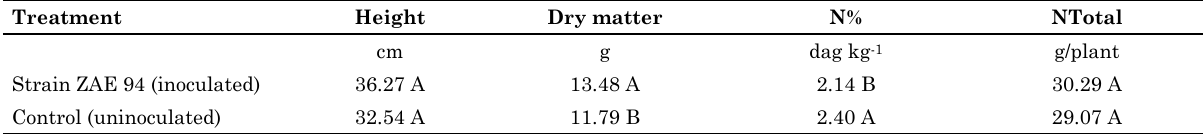
Table 1. Height, dry mass, percentage N (N%), and total N (NTotal) of shoots of maize plants inoculated or not with the diazotrophic bacterium H. seropedicae (strain ZAE94) grown in Vitória da Conquista, average of five